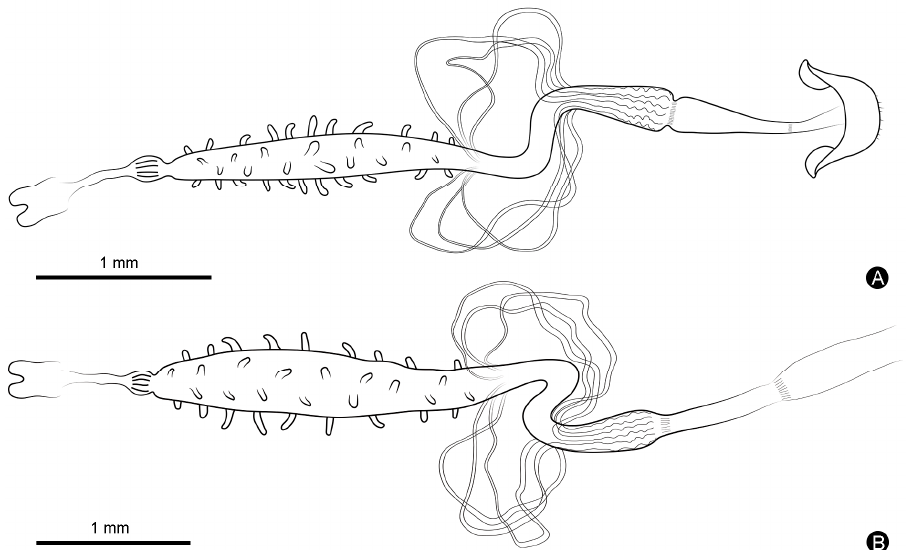
Figure 4. Drawings of the alimentary canal and Malpighian tubules of male and female M . ( O .) chinensis : ( A ) male alimentary canal and Malpighian tubules; ( B ) female alimentary canal and Malpighian tubules.